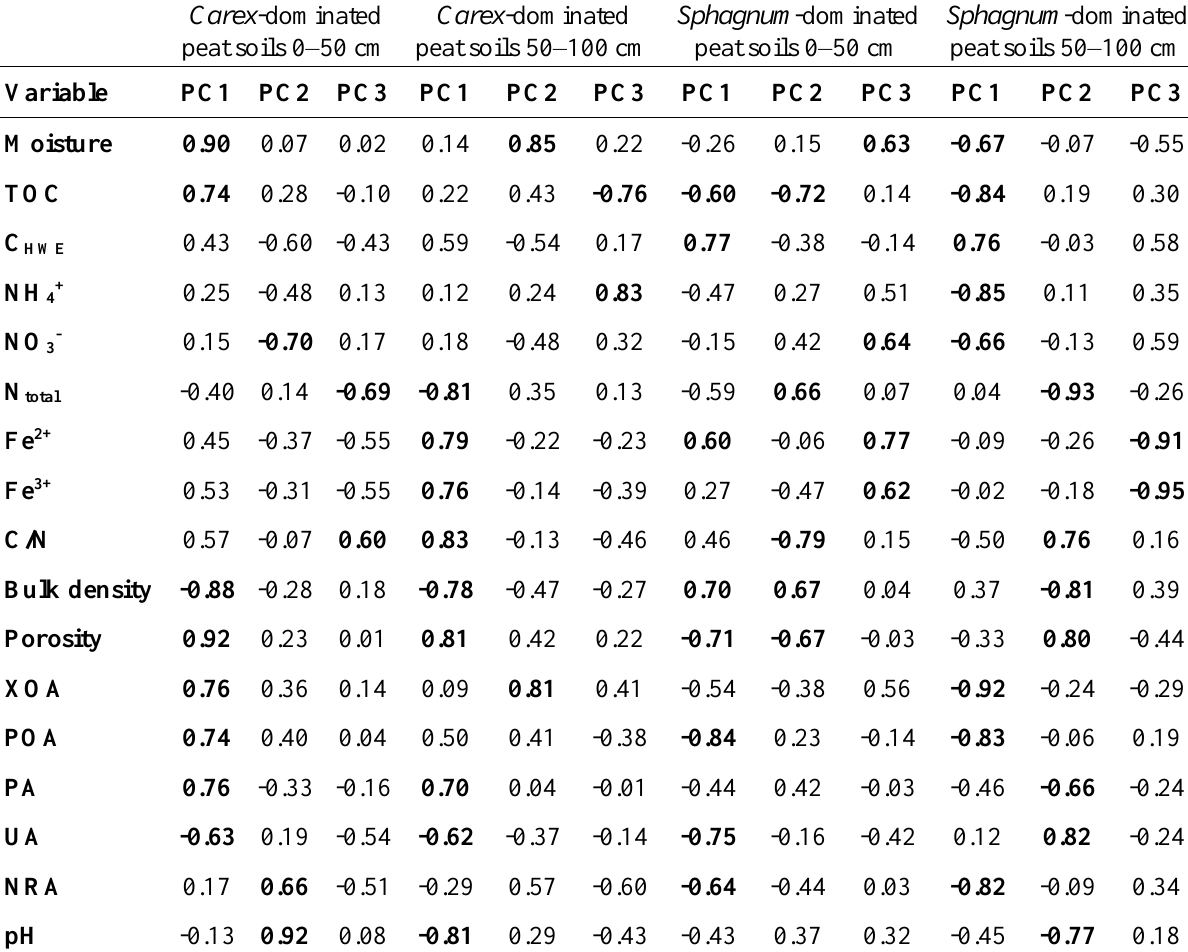
Table 5. Factor loadings and explained variance of three principal components in PCA. Significant correlation coefficients (significance level p < 0.05) are shown in bold . For acronyms, see Table